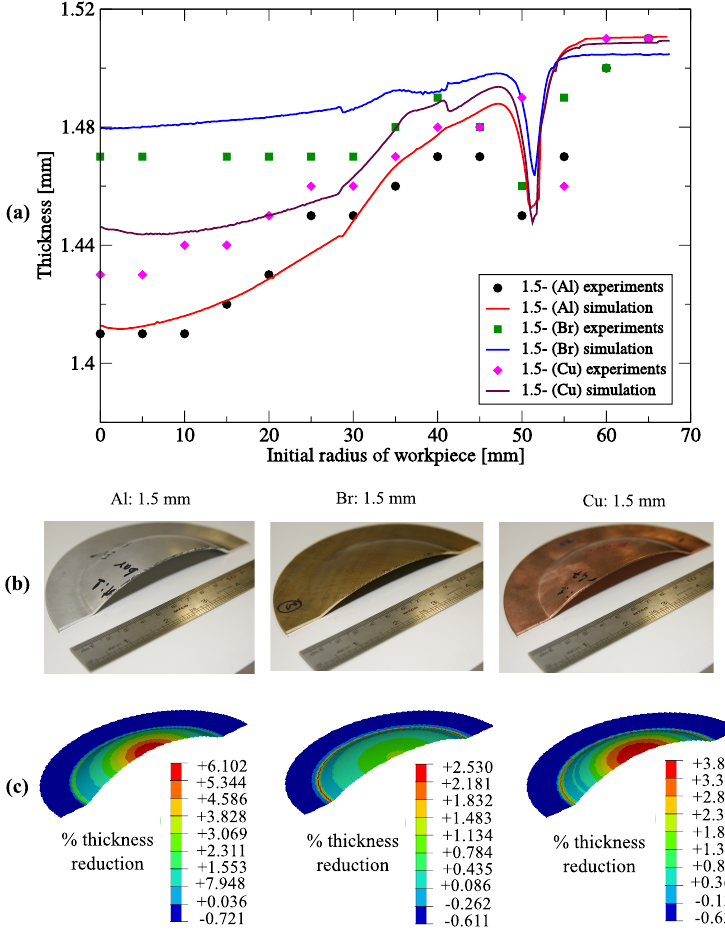
Figure 11. ( a ) Thickness variation in the 1.5 mm single deformed plate with respect to the initial radius of the workpiece. ( b ) Experimental and ( c ) numerical half section view of thickness